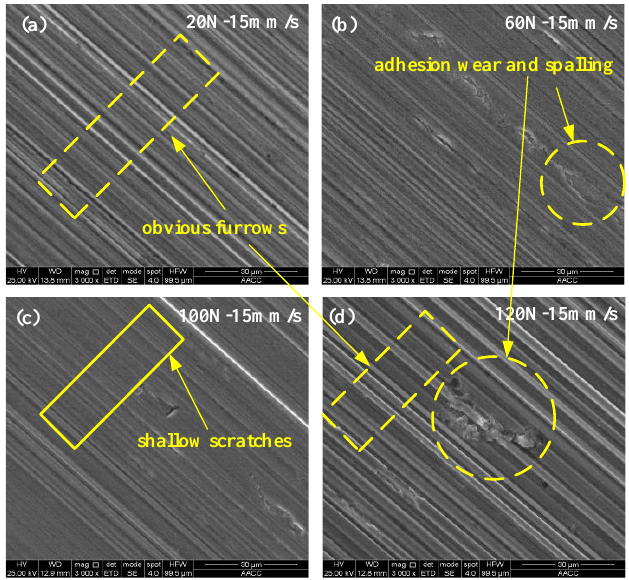
Figure 9. SEM of wear scars of sample oil #1 under different loads at the same sliding speed. ( a ) 20 N-15 mm/s; ( b ) 60 N-15 mm/s; ( c ) 100 N-15 mm/s; ( d ) 120 N-15 mm/s. Materials 2020 , 13 , x FOR PEER REVIEW